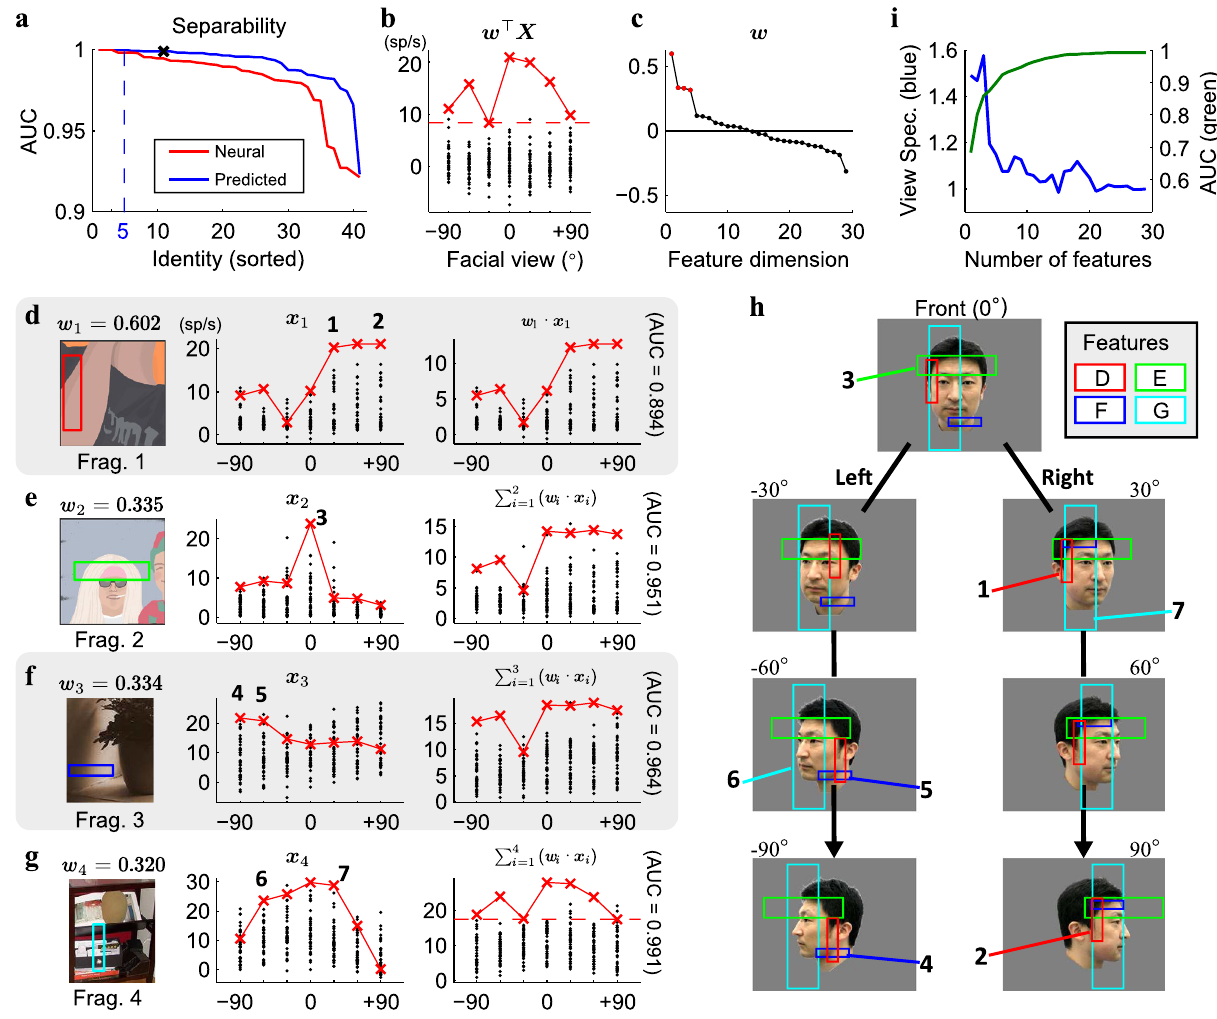
Figure 8. ( A ) The area under the ROC curve (AUC, vertical axis) for all pairs of one target identity and other 40 non-target identities (horizontal axis), evaluating how well target identities are separable from non-target identities in the space spanned by the predicted (blue) or neural (red) responses. ( B ) The seven faces of one target (red; see (H) for face images) and 280 faces of non-targets (black dots) represented along the axis w (AUC = 0.998, see the black “x” in ( A )). Here w is the axis that maximizes the separability in the space of the predicted responses. ( C ) The values of each element in w sorted in descending order. To search for key visual features that contribute to separation, we selected four elements with the largest absolute values (red dots). The features corresponding to these four elements are shown from ( D ) to ( G ). ( D ) The image fragment for the first visual feature (left) and its predicted responses to the faces of the target (red) and non-targets (black) identities (center). The responses are selective for right profiles (points 1 and 2) of the identity because of its good match with his right sideburn (areas 1 and 2 in ( H )). ( E ) The second feature specific to the front-face (point 3) for being matched with the hairline (area 3). ( F ) The third feature is selective to the left profiles (points 4 and 5) for being matched with the left chin (areas 4 and 5). ( G ) The fourth feature is broadly tuned to the front views (points 6 and 7) for being matched with horizontal components in the front-faces (areas 6 and 7). As the number of associated features increases (right side of ( D ) to ( G )), their linear combination becomes more specific to the target identity (AUC values increases from 0.894 to 0.991). (H) The sub-regions of the target faces matched with each feature. ( I ) View specificity (the ratio of the variance of seven target faces to the variance of all faces, normalized to set the last values to 1.0, blue) and AUC values (green) for 41 identities are averaged by increasing the number of features used for the linear combination (horizontal axis). Please note that a fragment including a face is replaced with an illustration because of the copy right regulation of Scientific report. Please refer to the SI text for the online link to the figure with the original